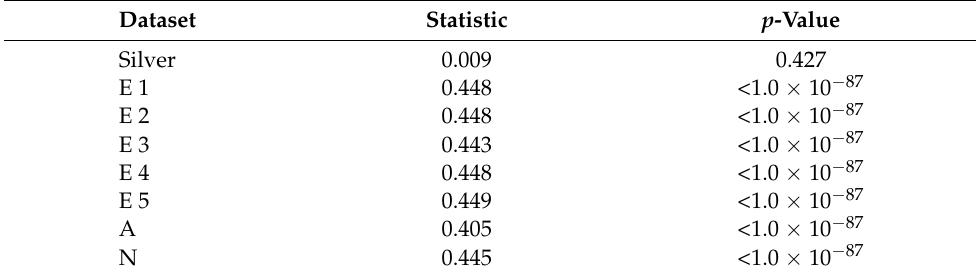
Table 3. Comparison of the distribution of average expression values of a dataset synthesized by Silver and that of other simulated datasets used for the evaluation of gene set analysis methods. Datasets labeled “E 1” to “E 5” have been introduced by Efron and Tibshirani [16], the dataset labeled “N” has been introduced by Nam and Kim [17], and the dataset labeled “A” has been introduced by Ackermann and Strimmer [15]. To make sure that the differences between the distributions of average expression values are not due to a constant shift in expression values, all datasets were centered prior to conducting two-sample Kolmogorov–Smirnov tests. As the results of Kolmogorov–Smirnov tests indicate, the distribution of average expression of datasets simulated by Silver shows no statistically significant difference from that of real data (GSE53757). However, there are significant differences between the average expression values of the other datasets and those of the real data. Dataset Statistic p -Value Silver 0.009 0.427 E 1